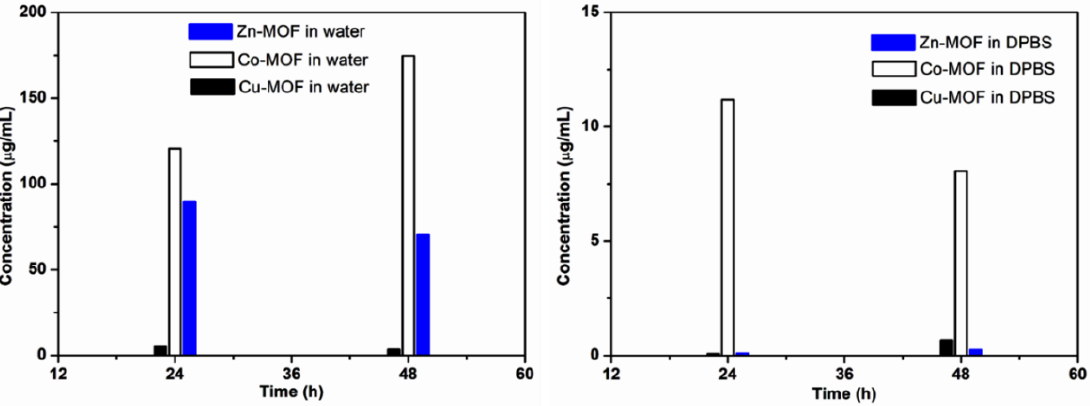
Figure 6. Metal (II) ions released from each MOF after immersion in deionized water ( left ) and DPBS ( right ) for 24 h and 48 h, as determined by ICP-MS.